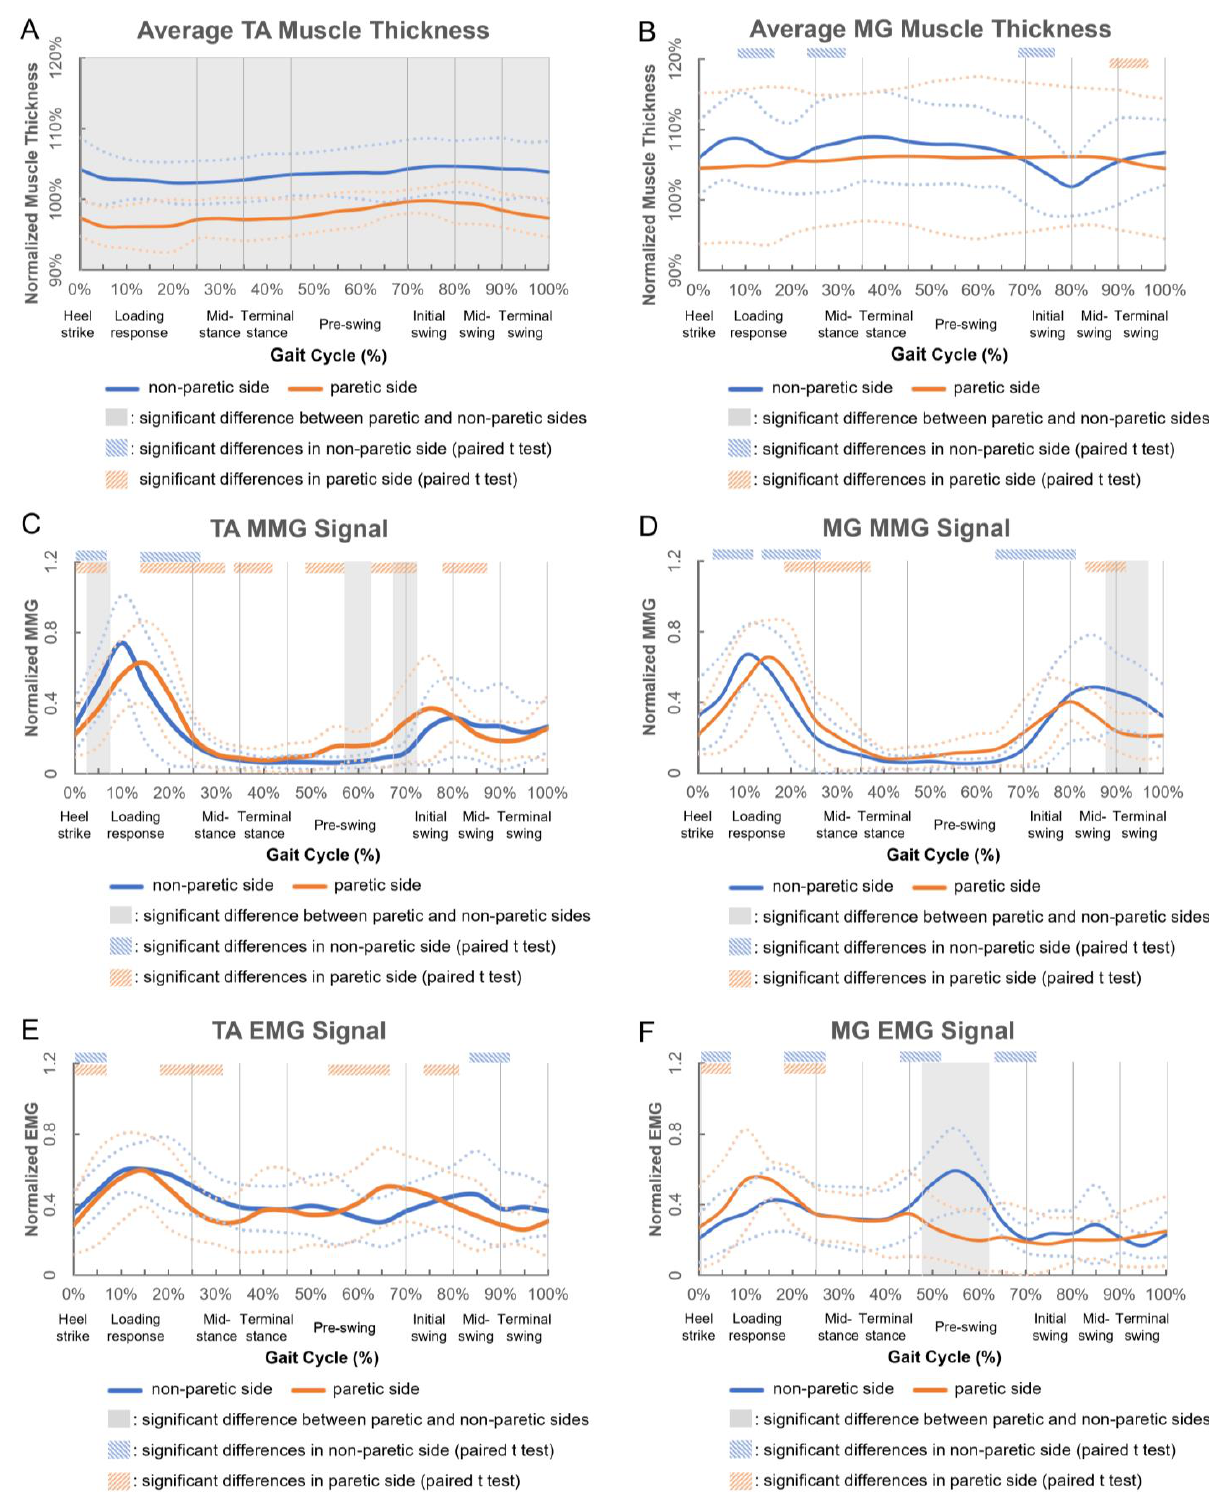
Figure 2. Changes in ( A ) average TA muscle thickness, ( B ) average MG muscle thickness, ( C ) mechanomyography (MMG) signal of TA muscle, ( D ) MMG signal of MG muscle, ( E ) electromyography (EMG) signal of TA muscle and ( F ) electromyography (EMG) signal of MG muscle of nine participants in a gait cycle (solid and dashed blue/orange lines indicate the mean and the standard deviation of nine participants, respectively; solid vertical gray lines indicate the typical gait events/phases of stroke survivors